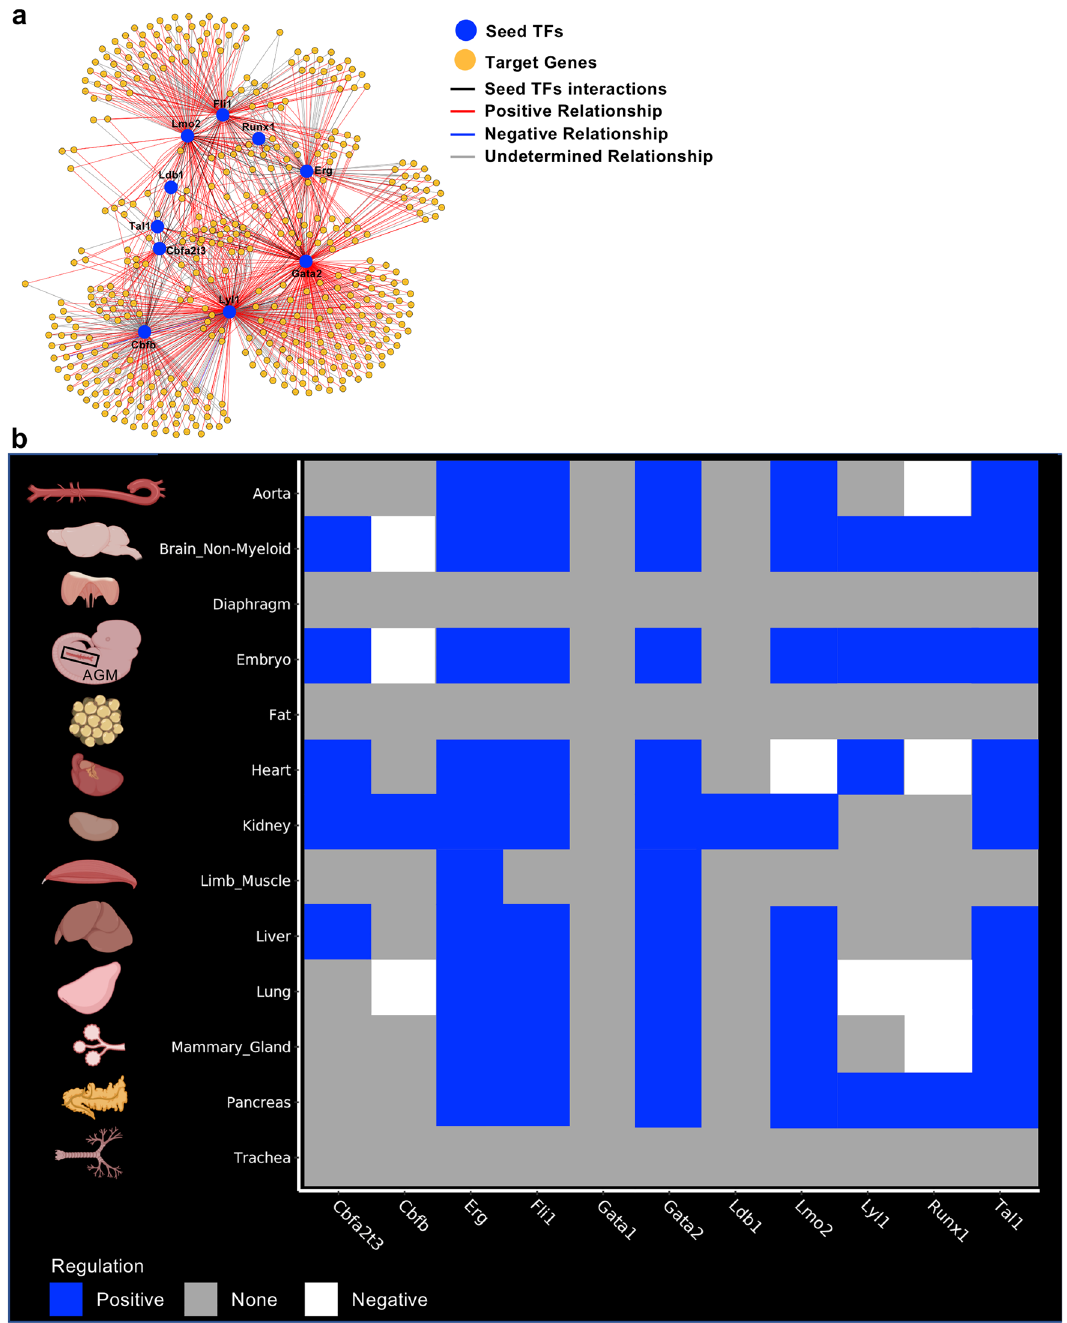
Figure 4. Gene regulatory network analysis identified target genes of seed transcription factors. ( a ) Gene regulatory network generated by scTarNet. Blue circles indicate seed TFs, yellow circles indicate target genes. Red lines show positive relationship between seed TF and target genes; ( b ) Heatmap summarizing the results of scTarNet for each indicated tissue. The colour code shows the type of regulation (positive, negative or none). Figure was made in BioRender—https:// biore nder.